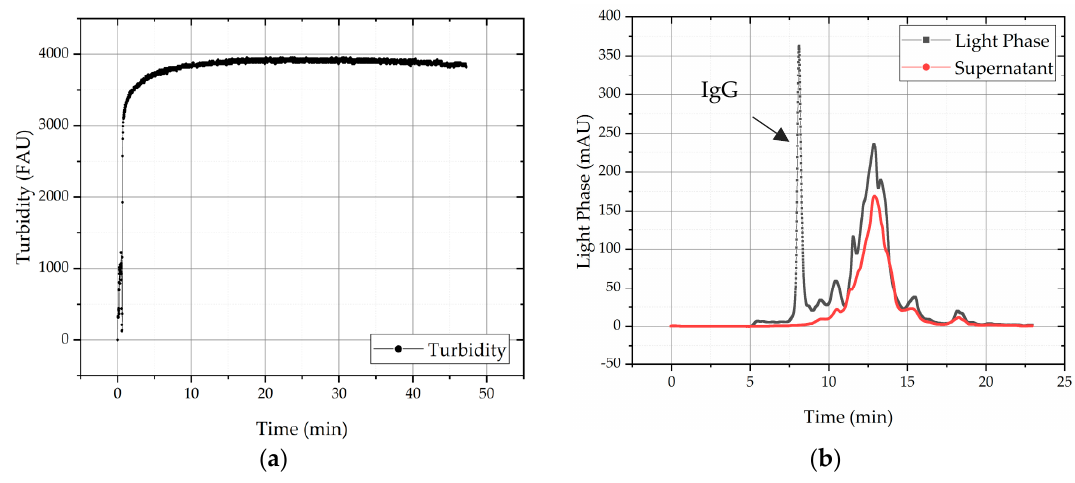
Figure 6. ( a ) Precipitation progress is displayed via turbidity signal. After 10 min the majority of proteins are already precipitated. ( b ) SEC ‐ chromatogram with the feed signal before (light phase, grey line) and the supernatant after precipitation (red line).